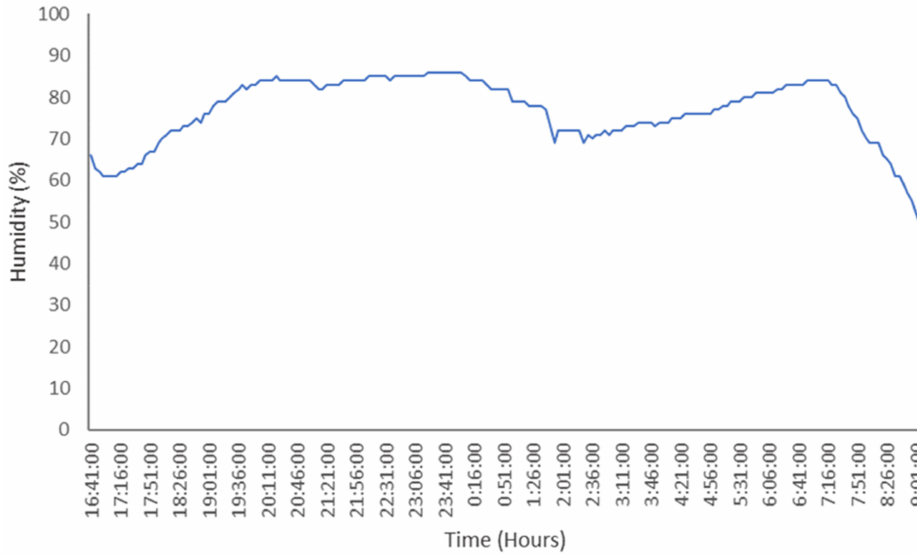
Figure 23. Monitored humidity throughout the